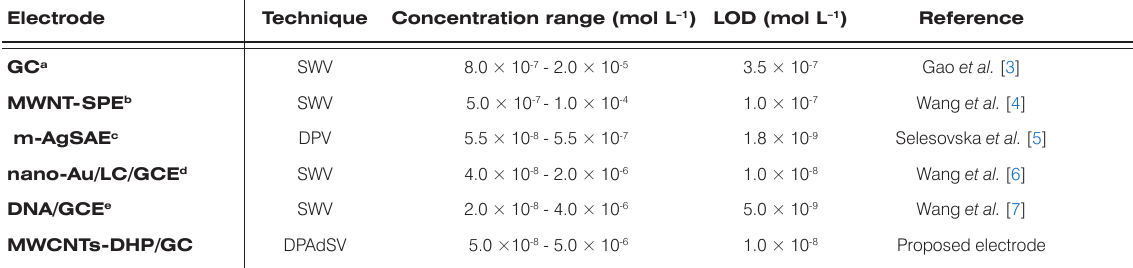
Table 2. Comparison of the analytical data between proposed electrode and some recently reported electrodes for MTX